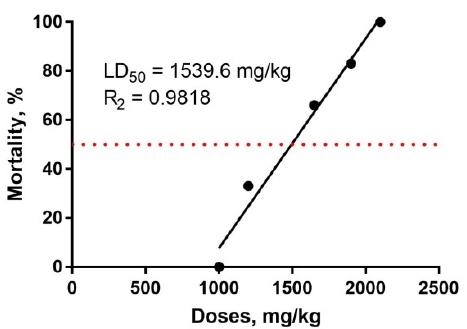
Figure 6. Acute oral toxicity of compound 2b in mice.